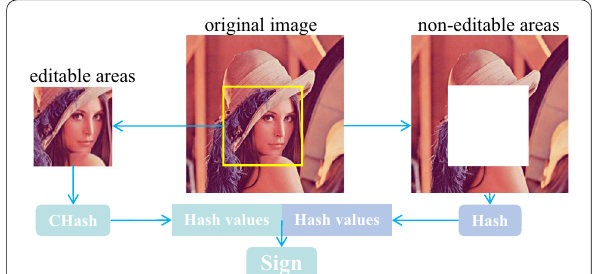
Fig. 2 Image blocks hashed by different hash